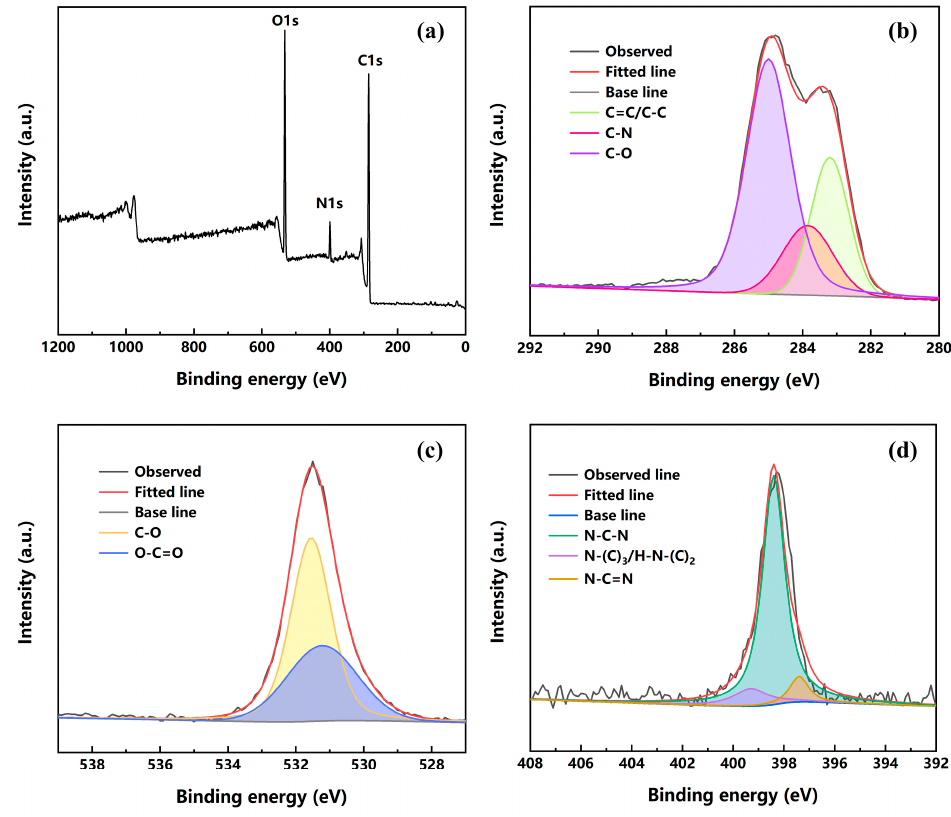
Figure 2. The XPS spectra of FUW ( a ); high-resolution XPS spectra of C1s ( b ), O1s ( c ), and N1s ( d ). The FTIR spectra of ORW, FUW, and epoxy resin are presented in Figure 3a and S1. Apparently, the spectrum of ORW displayed peaks at 1383 cm − 1 (C-H bending of cellulose), 1425 cm − 1 (C − H aromatic in plane deformation of lignin), 1463 cm − 1 (CH 2 bending of hemicellulose), 1506 cm − 1 (aromatic skeletal of lignin), and 1739 cm − 1 (C=O stretching of lignin), which were the characteristic peaks of cellulose, lignin, and hemicellulose [25,26]. Moreover, the spectrum of FUW showed peaks at 801 cm − 1 (C − H aromatic out-of-plane deformation), 1515 cm − 1 and 1614 cm − 1 (C=C aromatic stretching), and 2964 cm − 1 (C − H of epoxy group), which were the characteristic peaks of tris(oxiran-2-ylmethyl)amine/DDM epoxy resin [27,28]. The results of FTIR confirmed that FUW was successfully